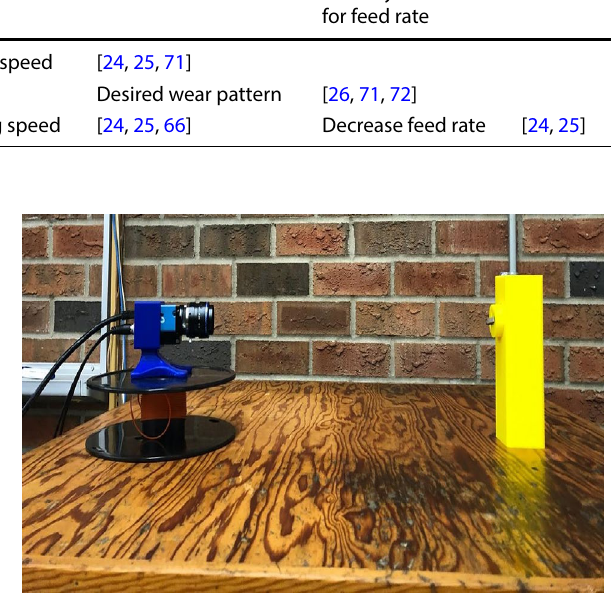
Fig. 5 Image capturing